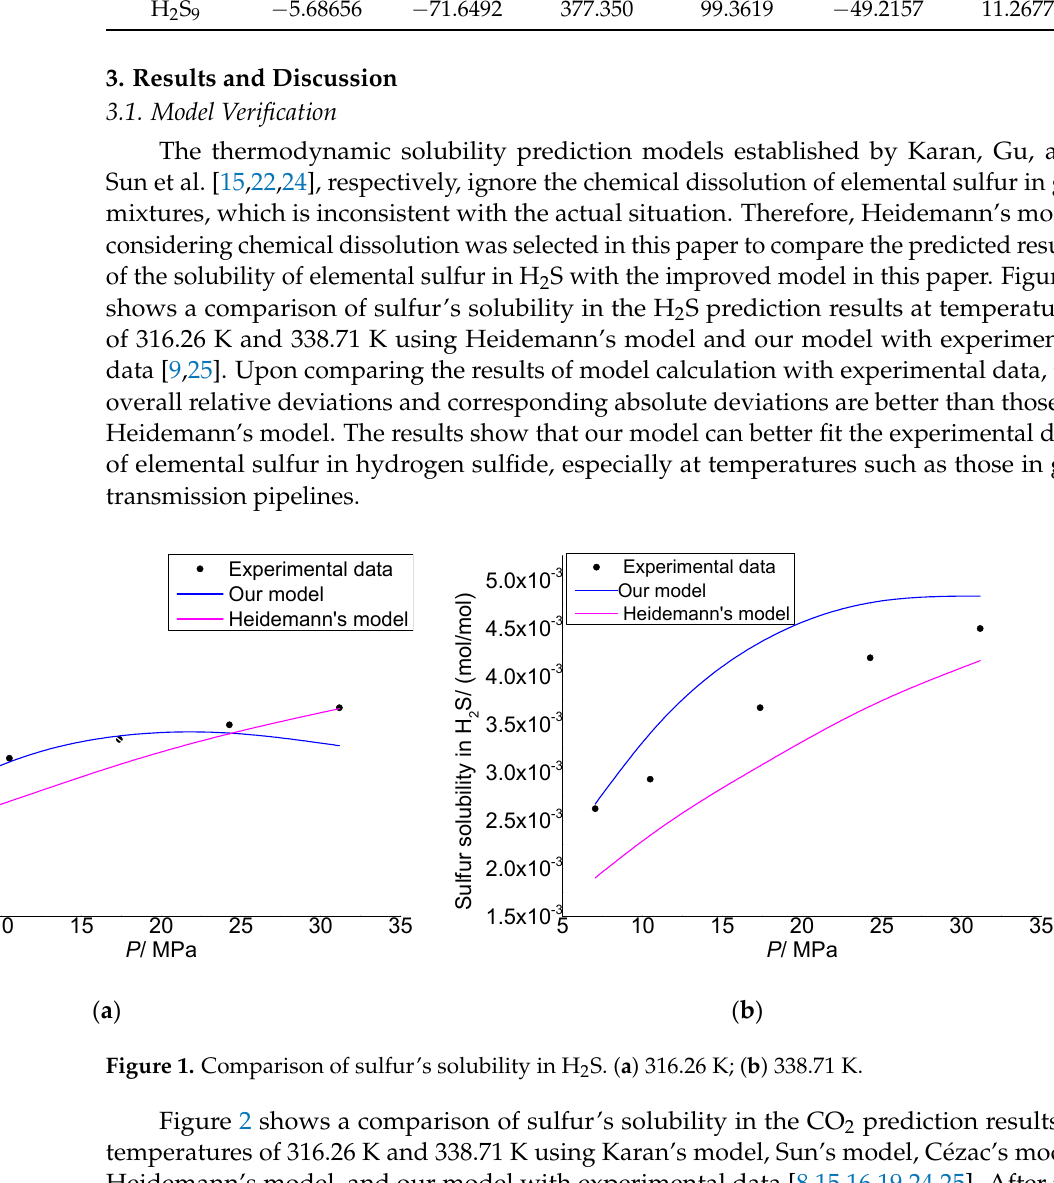
Table 2. Standard chemical potential constants.